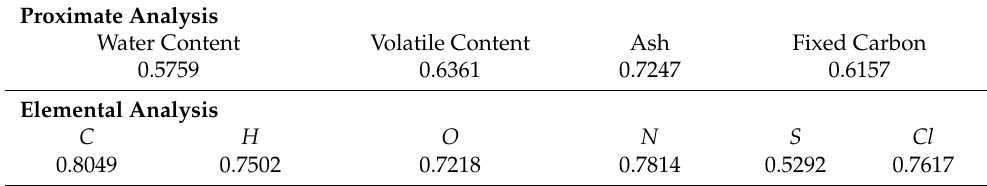
Table 3. Grey relational grade of selected factors.